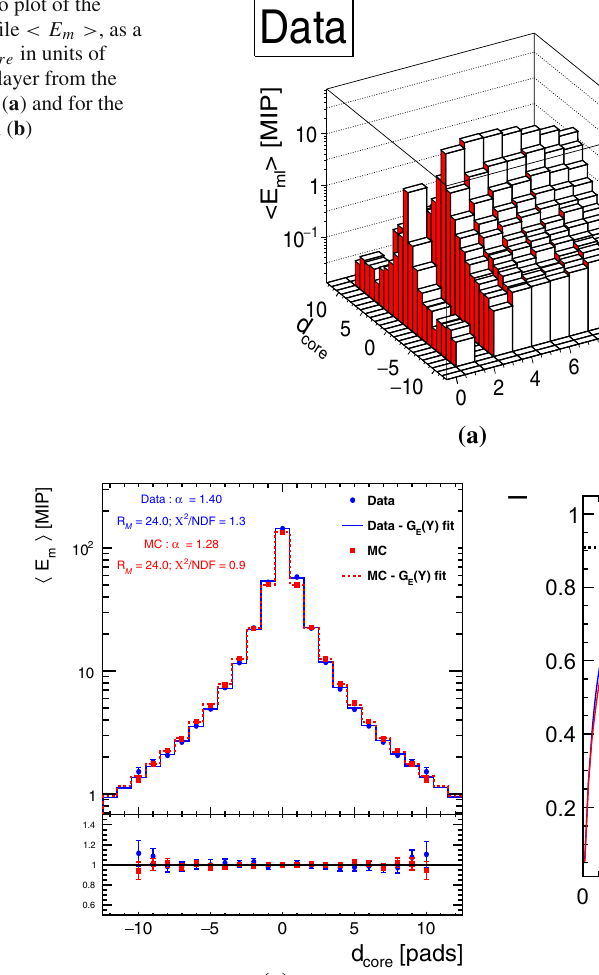
Fig. 24 A lego plot of the transverse profile < E m > , as a function of d core in units of pads, for each layer from the beam-test data ( a ) and for the MC simulation ( b )